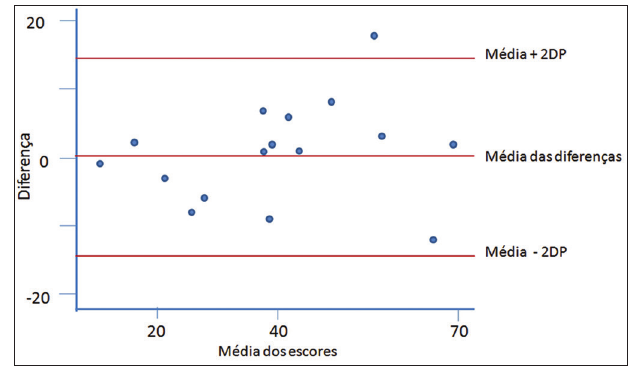
Figura 2. Representação gráfica proposta por Bland & Altman - repro - dutibilidade. Escores da primeira e segunda visita. No eixo y a diferença entre os escores da primeira e segunda aplicação do questionário e, no eixo x, a média das mesmas. Linha em vermelho central indicando a média da diferença entre os escores da primeira e segunda aplicação do questionário e linhas em vermelho periféricas indicando a média ± dois desvios padrões (1,96 x DP). DP: Desvio Padrão. um todo. Como resultado, podemos estar restringindo